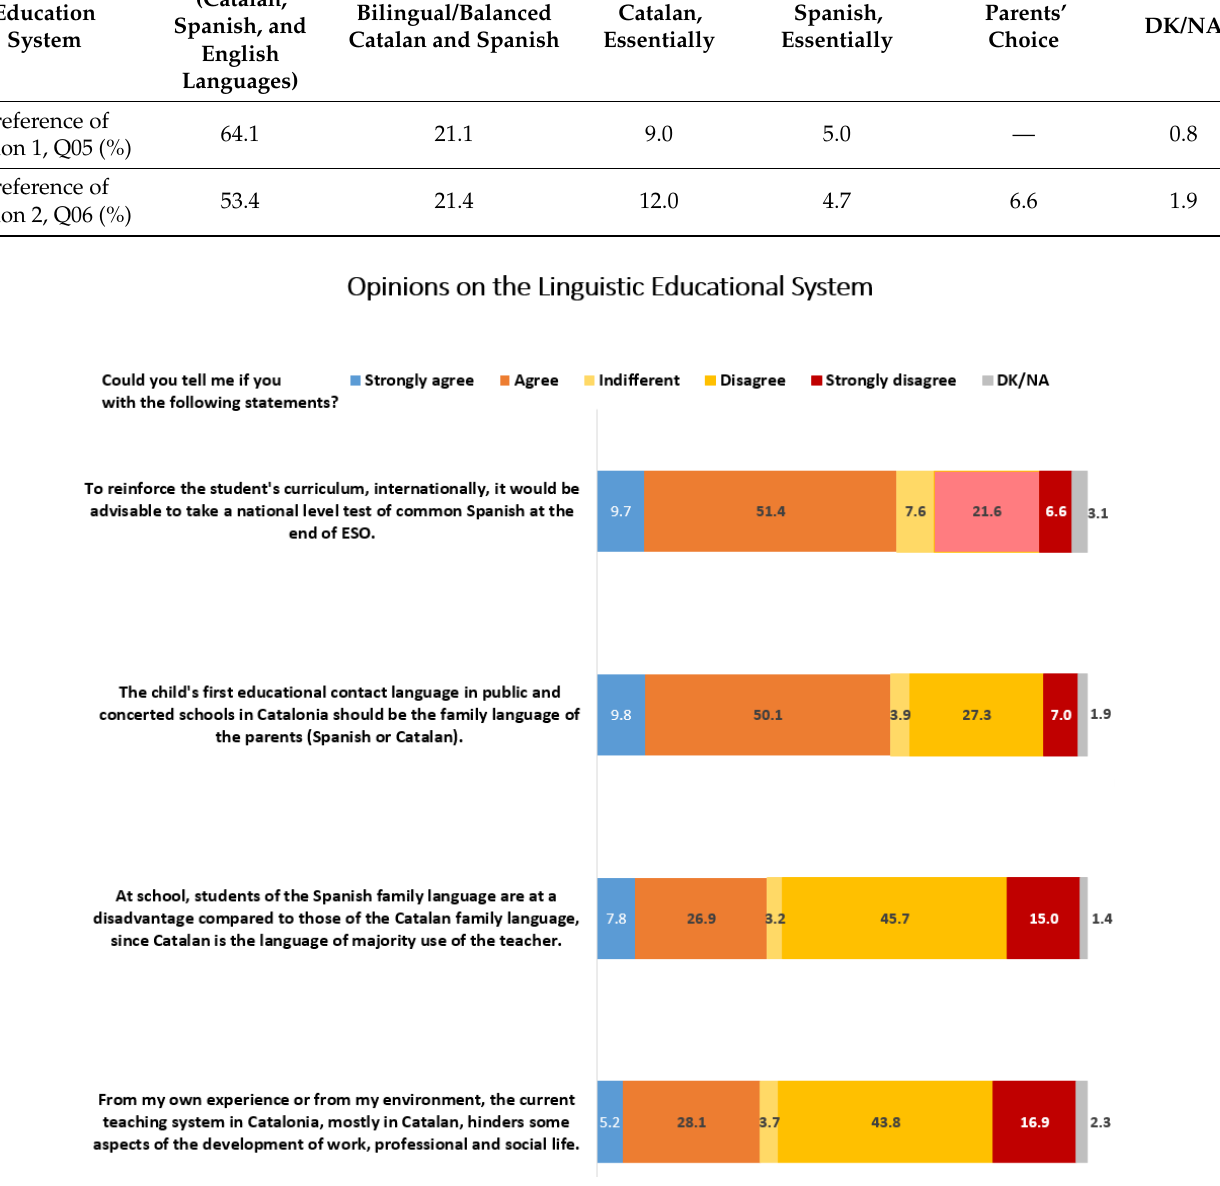
Figure 1. Distributions of preferences derived from several questions concerning the immersion linguistic educational system in Catalonia. There was significant agreement with the first statement, “ To reinforce student’s curriculum, internationally, it would be advisable to take a national test of the Spanish language at the end of secondary education ”, and also with the fourth statement, “ The child’s first educational contact language in public and concerted schools in Catalonia should be the family language of the parents (Spanish or Catalan) ”. In both cases, the support was above 60% in the entire population. Concerning the second and third statements, the degree of support was about 33%, although several differences were observed after dividing the population into segments. ESO: compulsory secondary